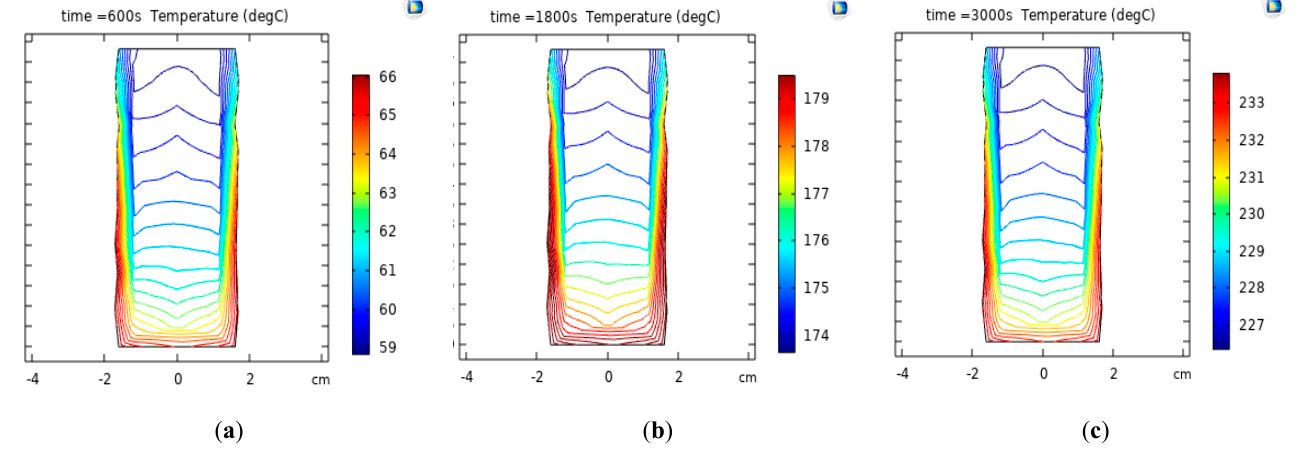
Figure 5. Isotherms inside the reactor at three different times: ( a ) 600 s, ( b ) 1800 s and ( c ) 3000 s.